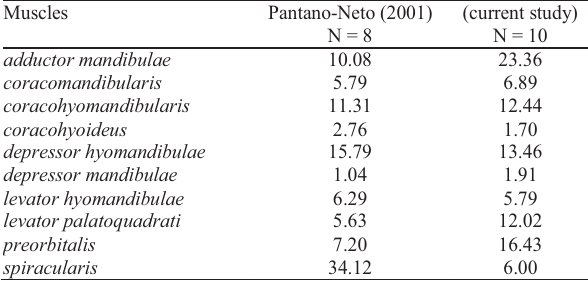
Fig. 2. Cranial musculature of Potamotrygon motoro at dorsal surface ( a ) and ventral surface ( b ). The left and right sides show the outer (superficial) and inner (deeper) layers of muscles, respectively. ( c) deeper layer of orobranchial musculature in the ventral view, after removing the muscles Dem, Deh and Spi.